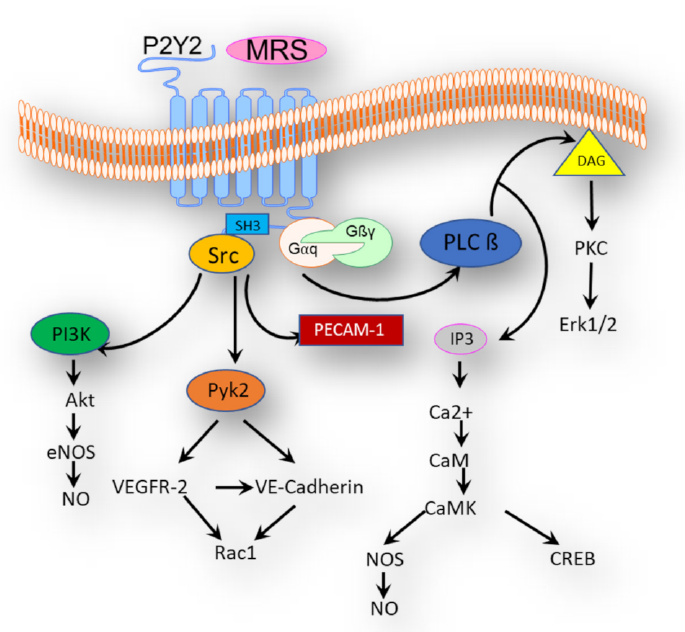
Figure 2. P2Y2 mediated signaling pathways that are generally expected in different cell types and tissues, including the pulmonary vasculature. Abbreviations: MRS = MRS2768; DAG = diacylglycerol; PKC = proteinkinase C; Erk1/2 = extracellular-signal regulated kinases; PLC β = phospholipase C ( β ); IP3 = inositol trisphosphate; CaM = calmodulin; CaMK = Ca 2+ /calmodulin-dependent protein kinase; CREB = cAMP response element-binding protein; NOS = nitric oxide (NO) synthase; SH3 = SRC homology 3 domain; G α , G β , and G γ = G-protein subunits ( α , β and γ ); Src = proto-oncogene tyrosine-protein kinase; PECAM-1 = platelet endothelial cell adhesion molecule; Pyk2 = protein tyro- sine kinase 2 beta; VEGFR-2 = vascular endothelial growth factor receptor 2; VE-cadherin = vascular endothelial cadherin; Rac1 = Ras-related C3 botulinum toxin substrate 1; PI3K = phosphoinositide 3-kinases; Akt = protein kinase B (PKB)